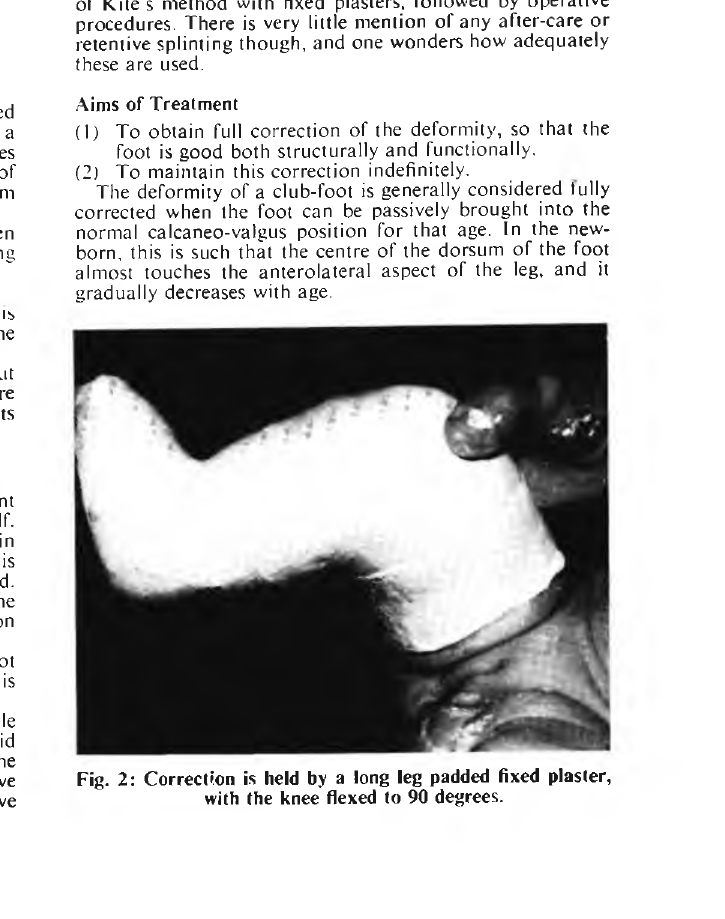
Fig. 2: Correction is held by a long leg padded fixed plaster, with the knee flexed to 90